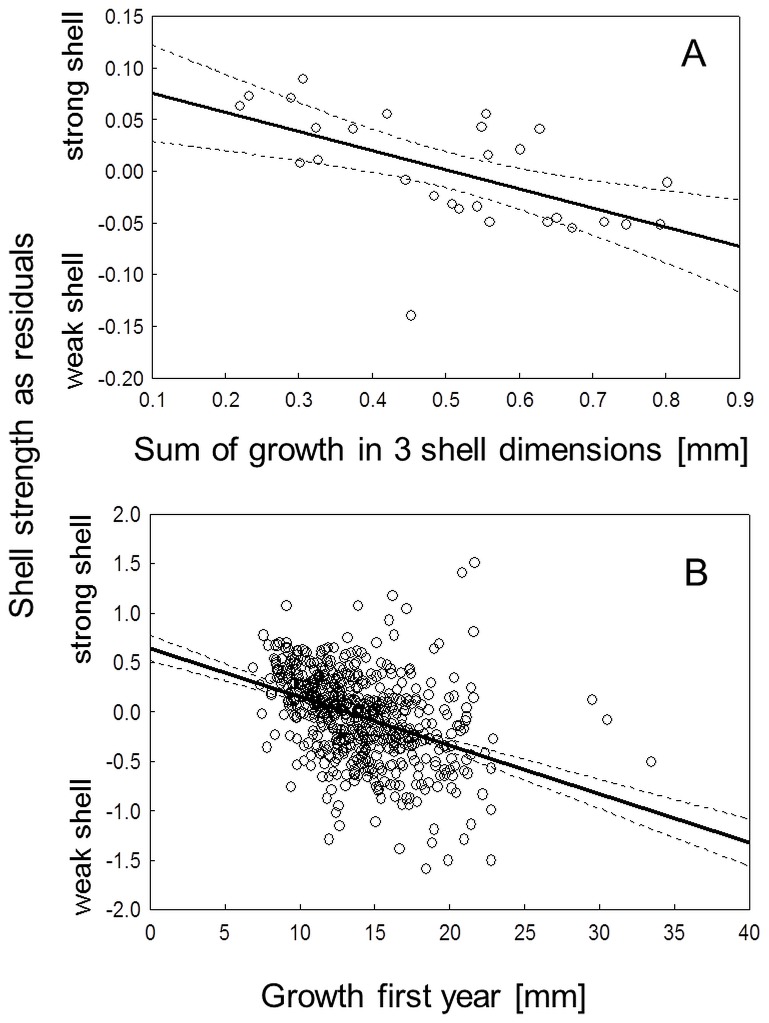
Shell strength and growth are correlated in zebra mussels.
A: experimental data as mean growth (measured in mm increase in the 3 shell dimensions length, height, and width) in relation to the corresponding shell strength means from the 28 experimental tanks with 16 mussels each. B: field data as individual growth in the first year post settlement in relation to shell strength of 556 mussels. Dashed lines denote 95% confidence intervals for the fit.